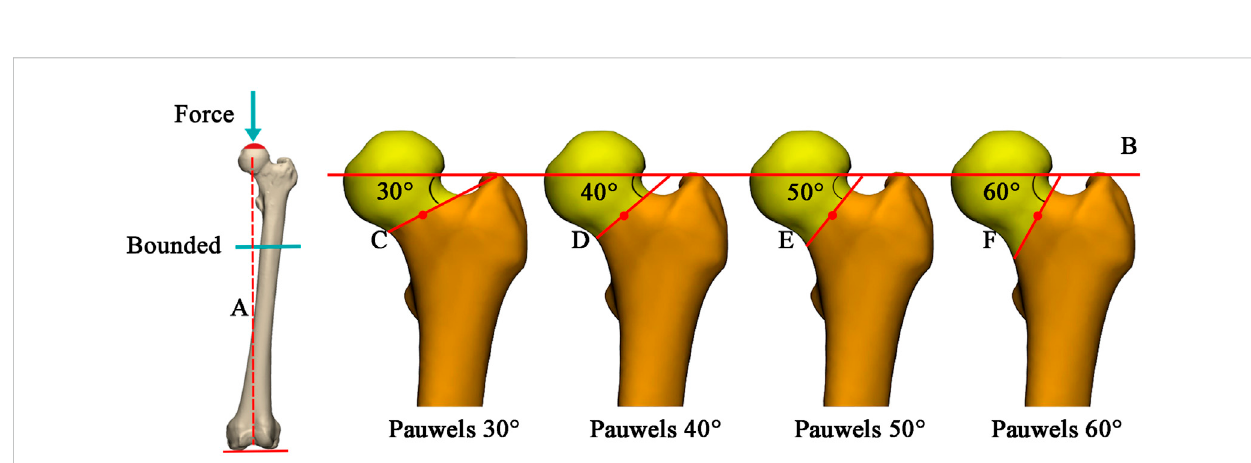
FIGURE 2 Illustrationof theloading and femoral neckfracturemodel. (A) mechanical axis of thefemur; (B) parallel lines ofhorizontal lines connecting theiliac crest on both sides and passing through the center of the femoral head; (C – F) : fracture lines of Pauwels 30 ° , 40 ° , 50 ° , and 60 ° , respectively, passing through the center of the femoral